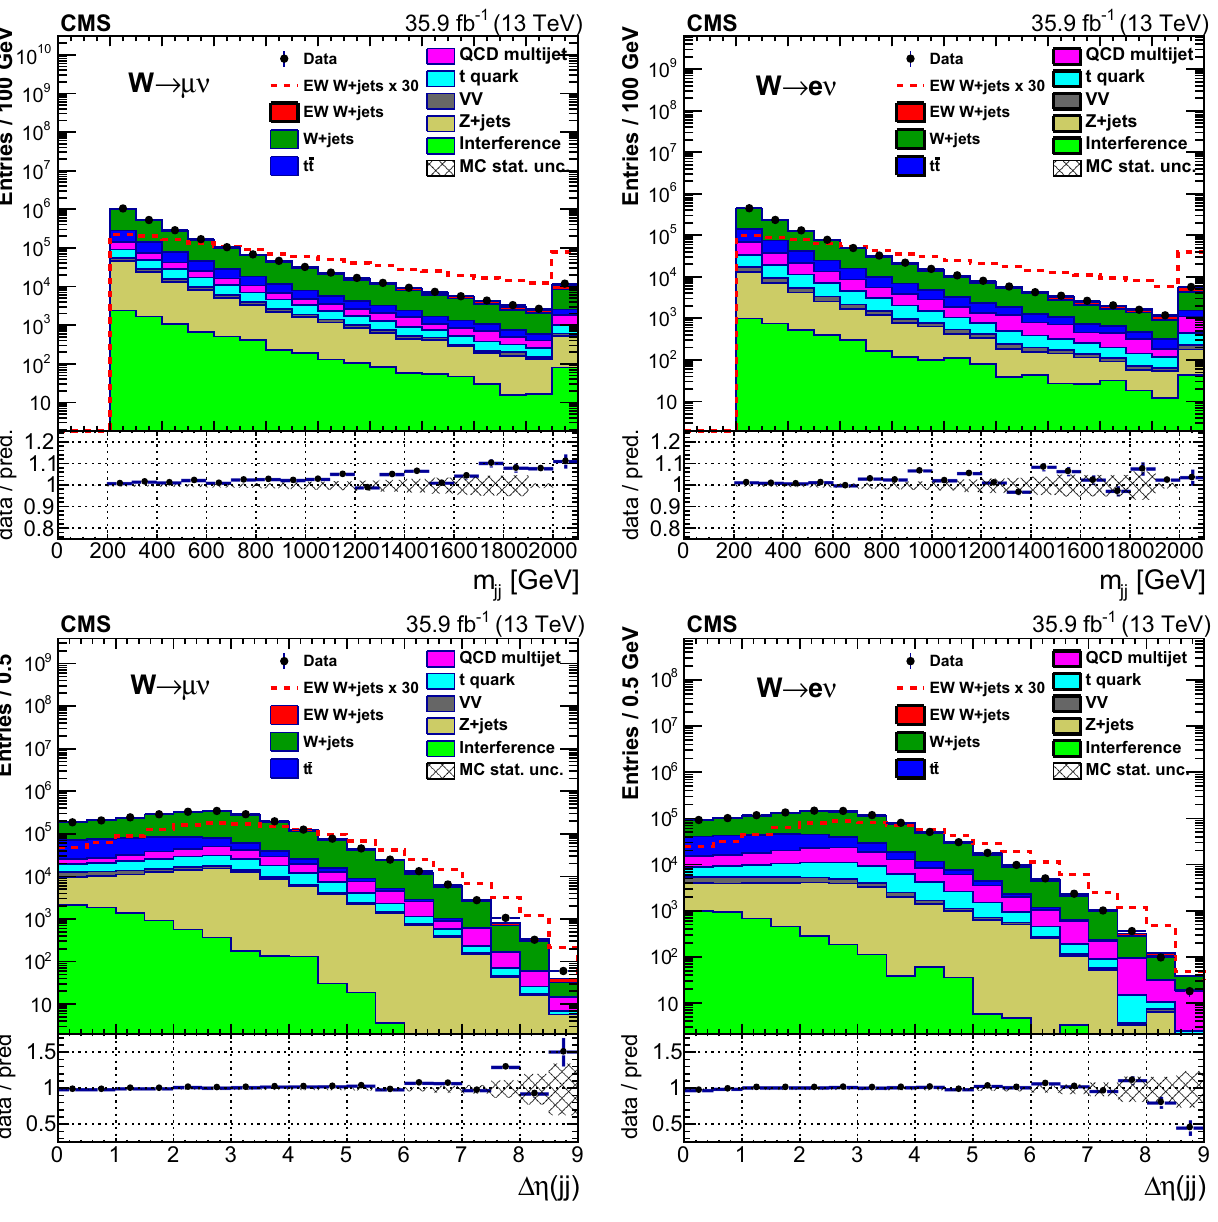
Fig. 5 Dijet invariant mass (upper) and pseudorapidity difference (lower) distributions after the event preselection, in the muon (left) and electron (right) channels. In all plots the last bin contains overflow events